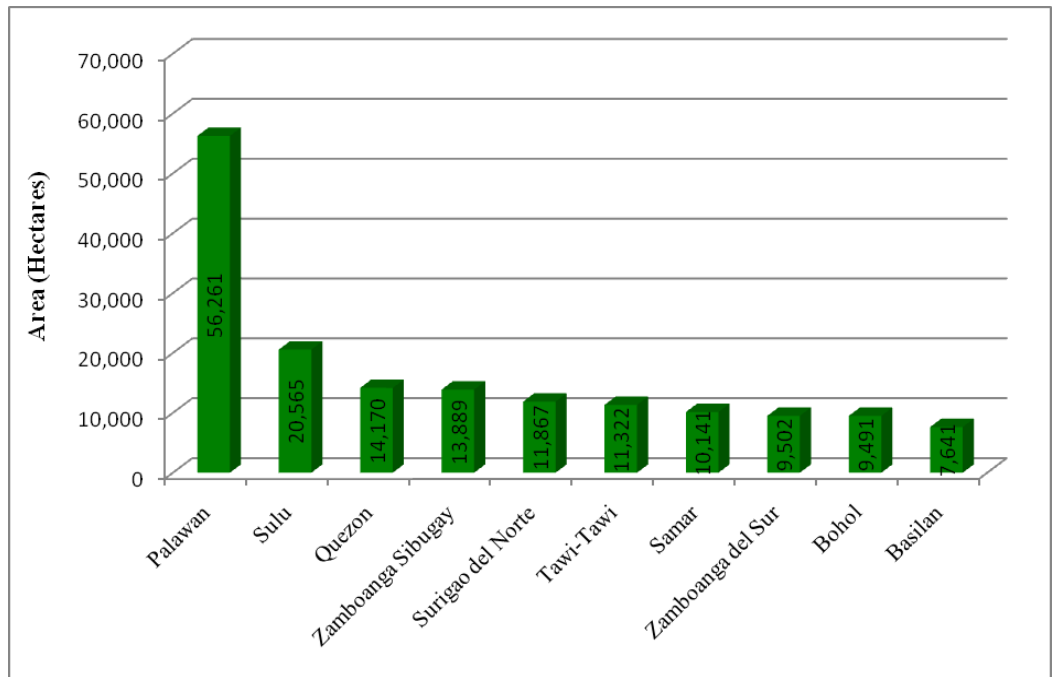
Figure 7. Provinces with majority of mangrove extent.